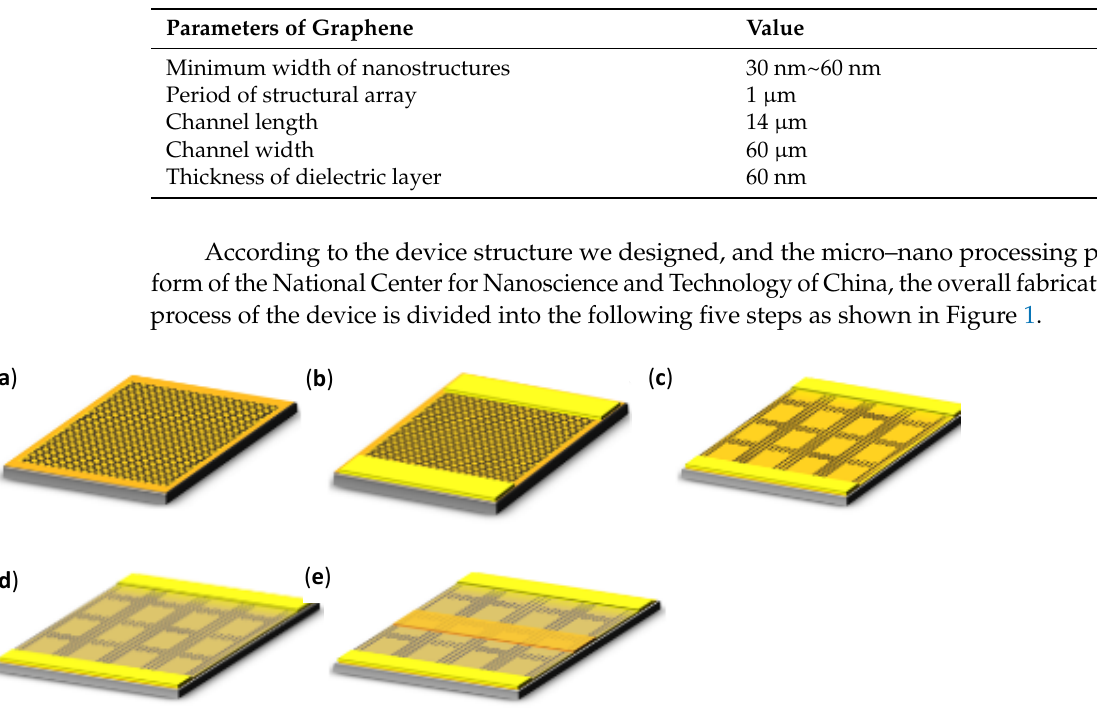
Figure 1. The fabrication process of the graphene terahertz field-effect transistor (FET) detector. ( a ) Chemical vapor deposition (CVD) preparation and substrate transfer of graphene. ( b ) Fabrication of source and drain electrodes. ( c ) Fabrication of graphene nanogrid by electron-beam lithography (EBL). ( d ) CVD deposition of the Si 3 N 4 dielectric layer. ( e ) Fabrication of the gate electrode.